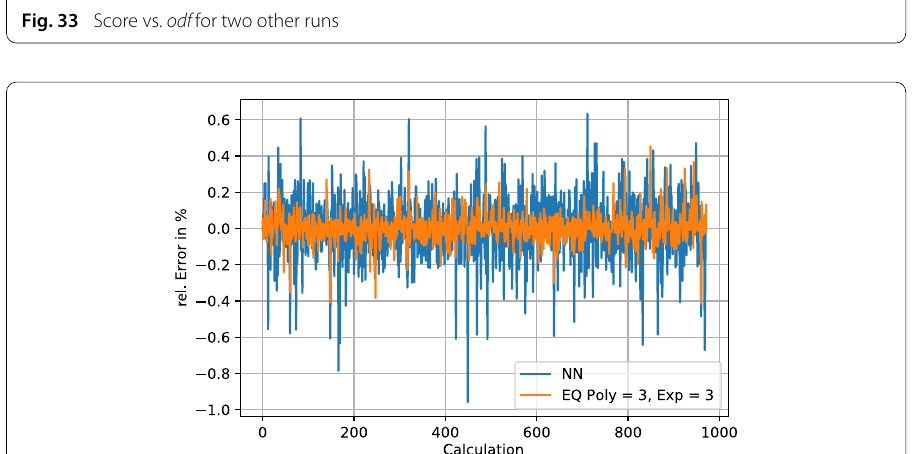
Fig. 34 Rel. error for comparison of NN vs. EQ Poly = 3 and Exp = 3 model